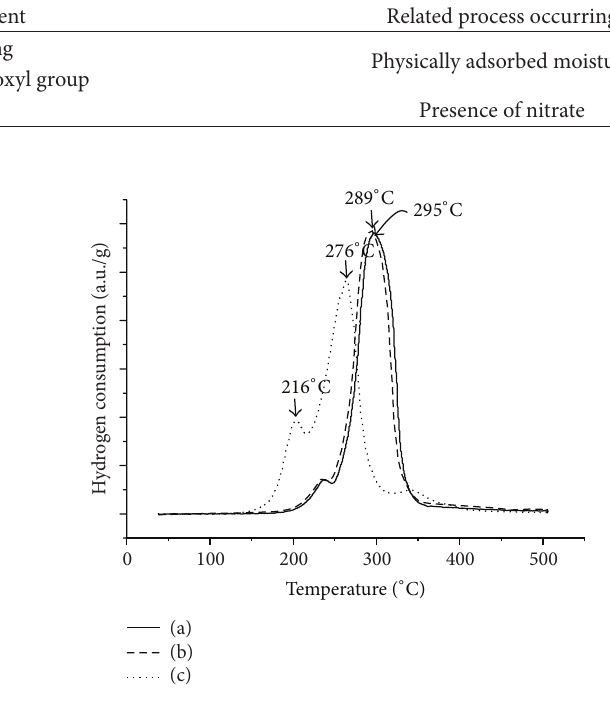
Figure 4: The TPR profiles of Cu-Ni/TiO 2 photocatalysts calcined at different temperatures: (a) 200, (b) 180, and (c) 300 ∘